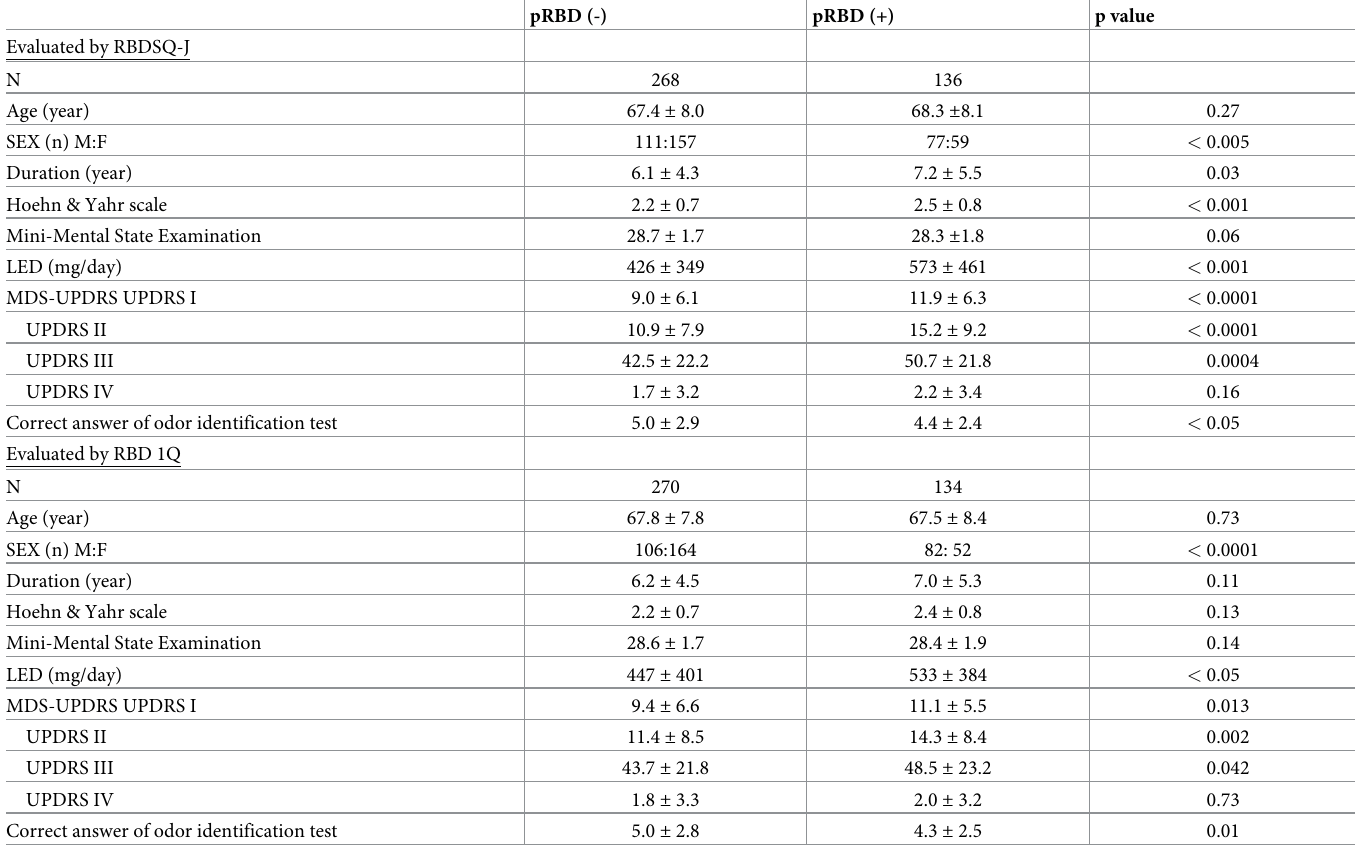
Table 3. Comparison between patients with PD with and without